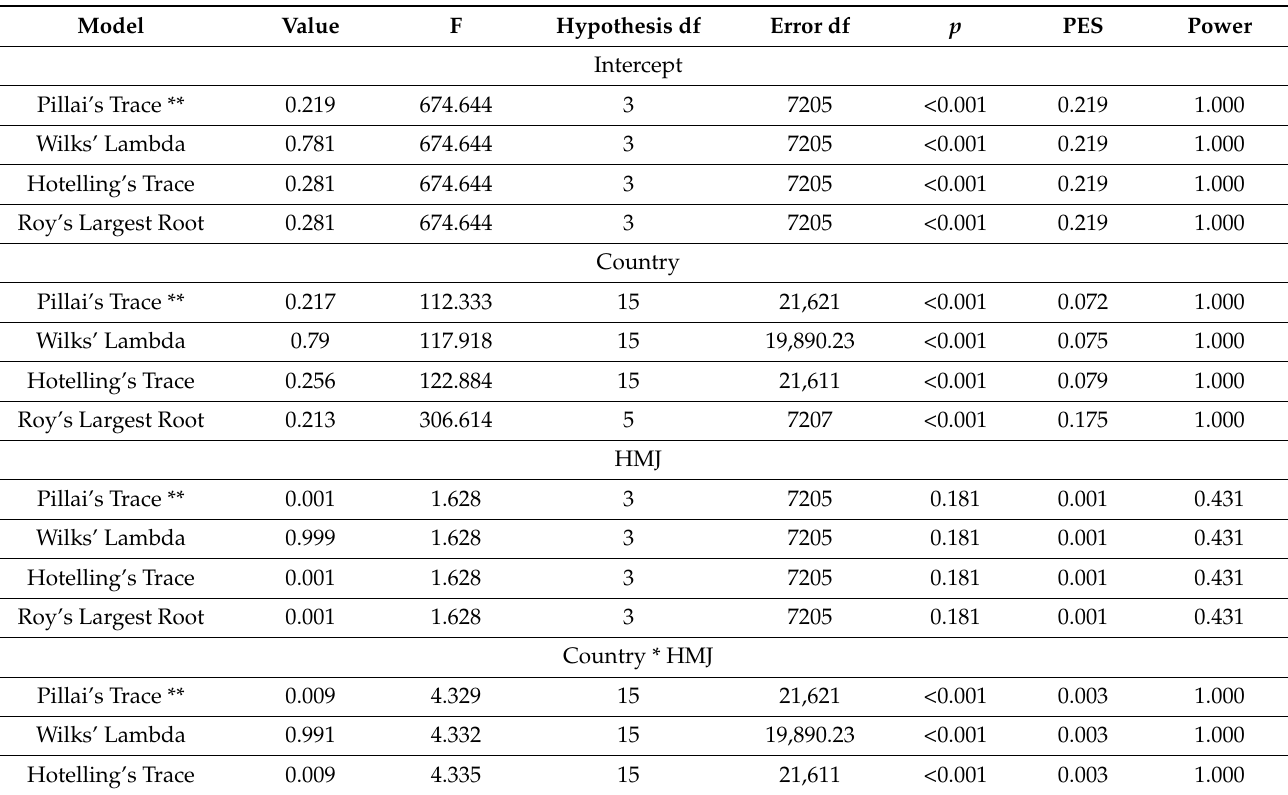
Table A4. A multivariate test of the associations between occupational PA, country of residence, and